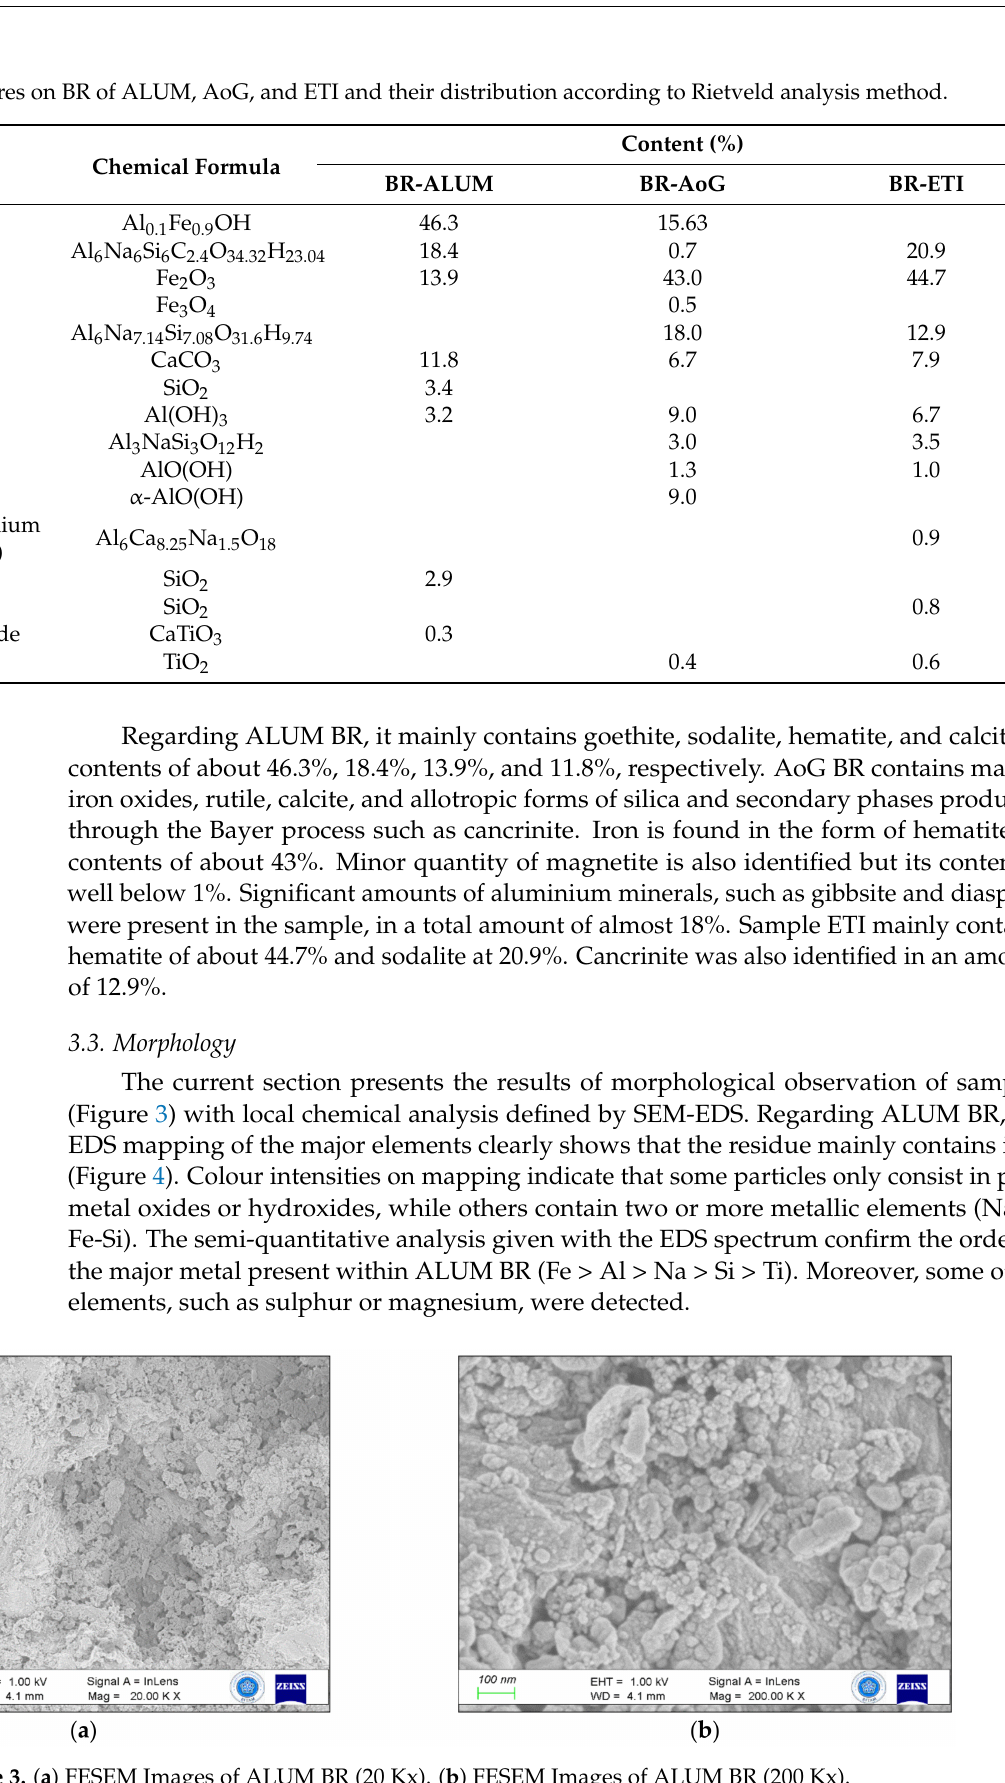
Figure 3. ( a ) FESEM Images of ALUM BR (20 Kx). ( b ) FESEM Images of ALUM BR (200